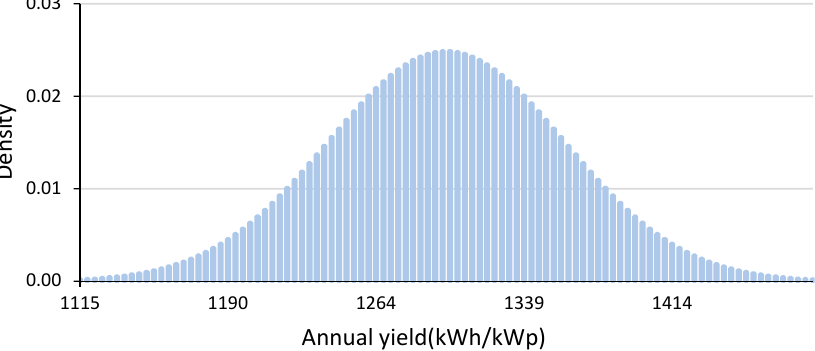
Annual yield(kWh/kWp) Figure 1. Probability density function (PDF) of the annual yield used in the Monte Carlo probabilistic method.